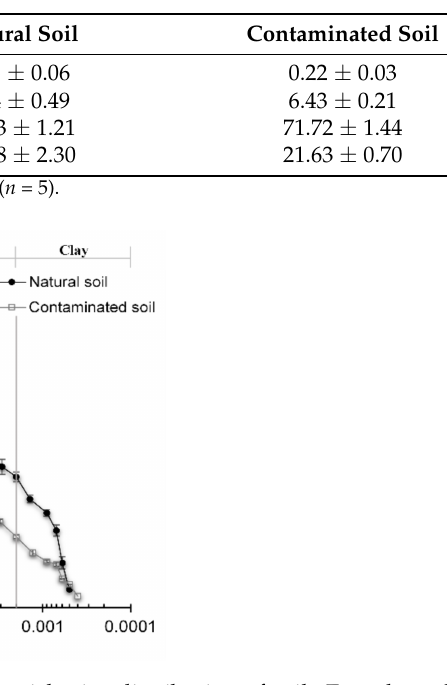
Figure 2. Impact of diesel contamination on particle size distribution of soil. Error bars denote standard